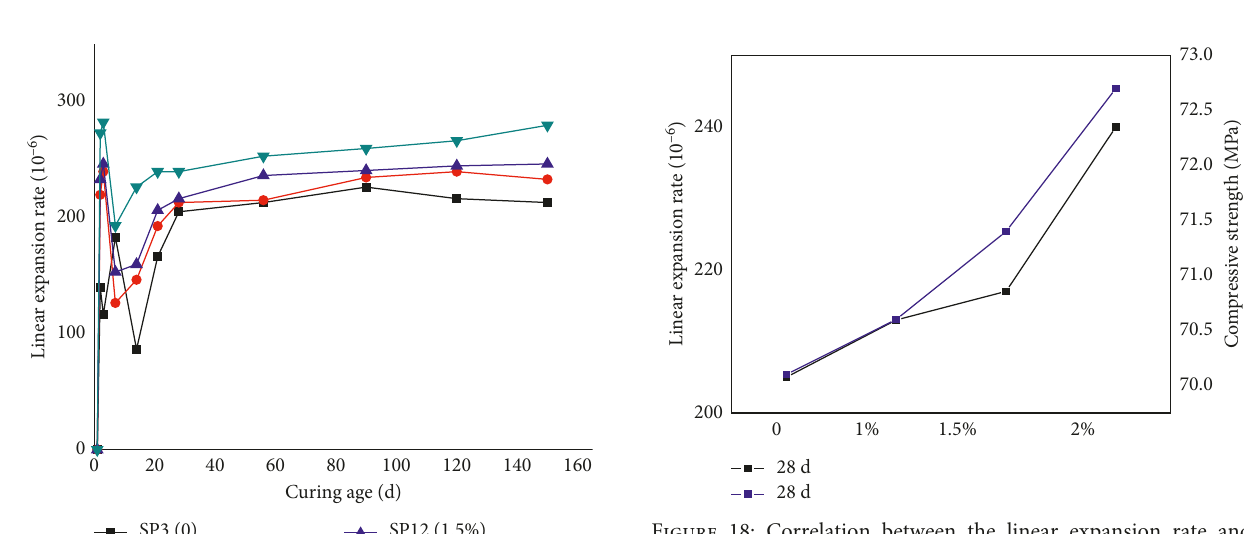
Figure 18: Correlation between the linear expansion rate and compressive strength.